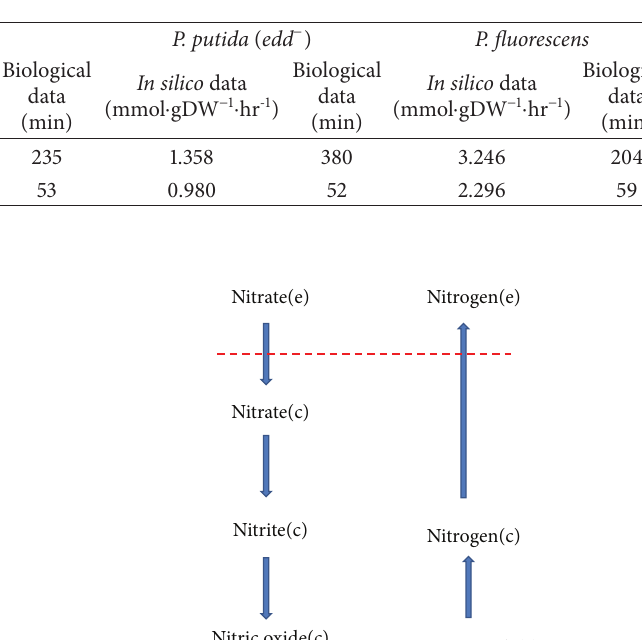
Table2:GrowthratesofiMO1086,iJP962,andiSB1139onfructoseandsuccinateasthesolecarbonsources.Biologicaldatarepresentdoubling times and in silico results represent computational growth rates.